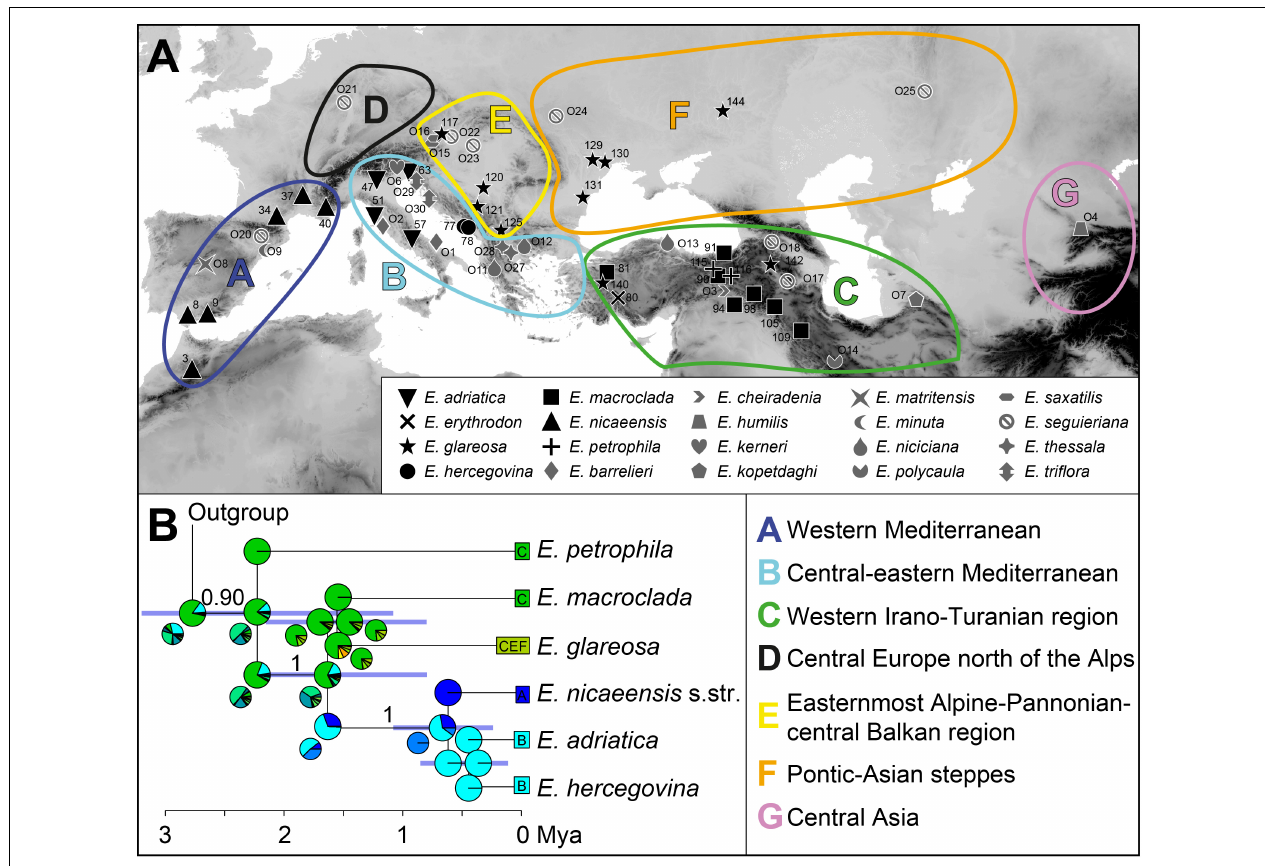
FIGURE 2 | (A) Geographic areas and geographic provenance of the investigated populations. (B) The time-calibrated species tree inferred with SNAPP and used in the biogeographic analysis with BioGeoBEARS. Numbers above branches are posterior probabilities > 0.80, and the horizontal bars correspond to 95% highest posterior densities (HPD) for the age estimates. Pie charts at each node show the marginal probabilities of alternative ancestral ranges obtained from the BioGeoBEARS analysis under the DEC + J model. In addition, smaller pie charts resulting from the DEC model are presented in cases where the reconstruction between the models differed. Colours in pie charts correspond to the geographic areas in A. The trees, including outgroup taxa, are presented in Supplementary Figure 3 . Population numbers correspond to Supplementary Table 1